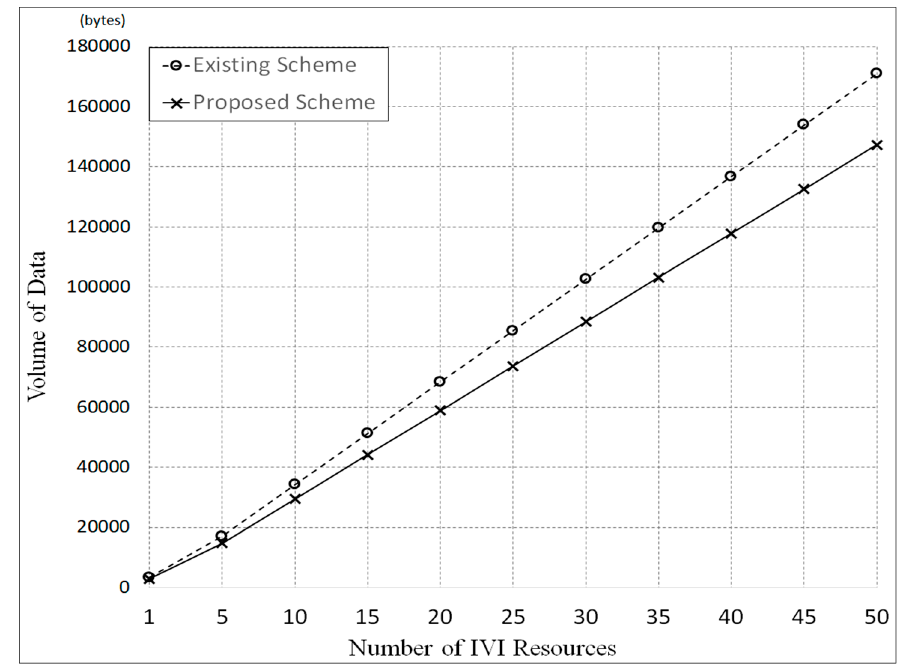
Figure 13. Comparison of data volume used in IVI resources control by simulation.